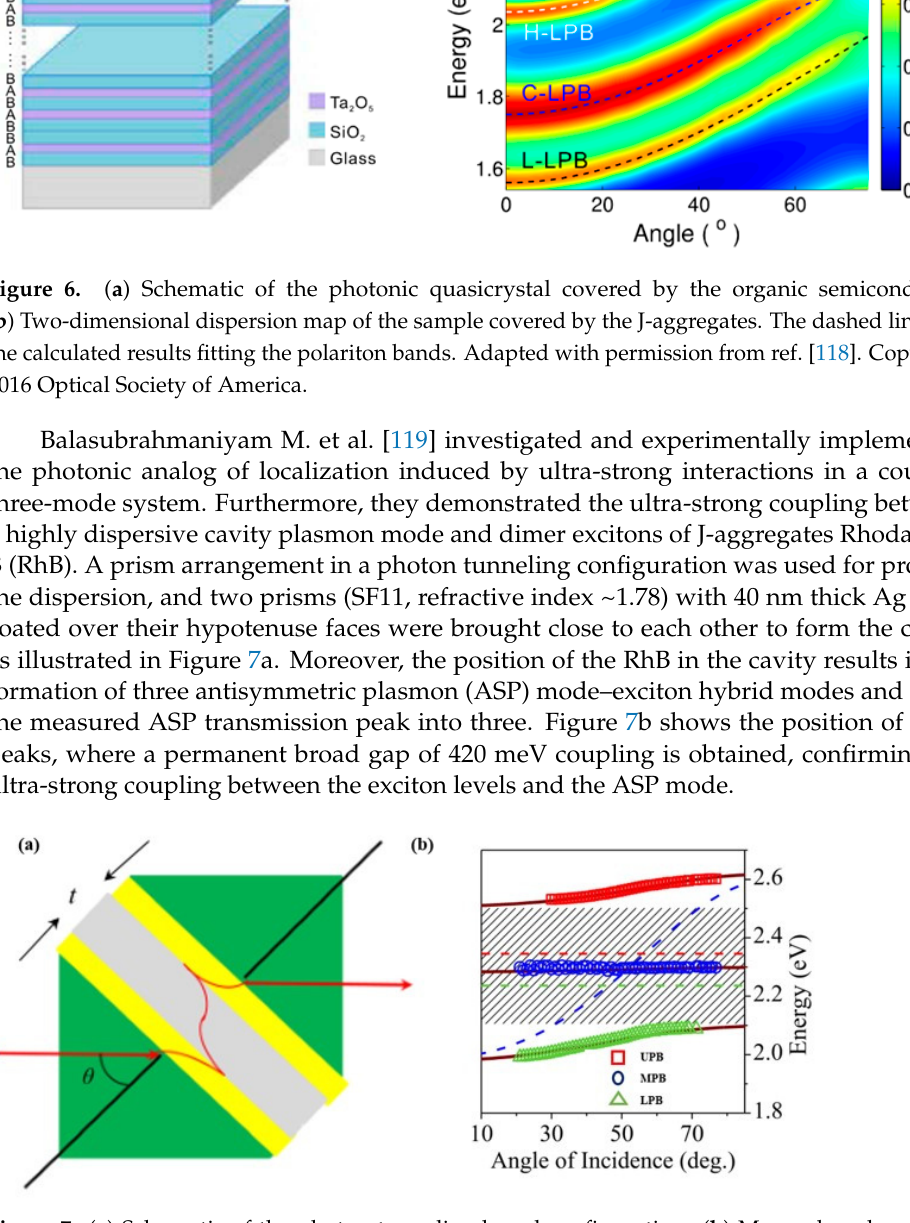
Figure 7. ( a ) Schematic of the photon tunneling based configuration. ( b ) Mapped peak position showing the dispersion of the ASP–exciton hybrid modes. Adapted with permission from Ref. [119]. Copyright 2017 American Institute of Physics.